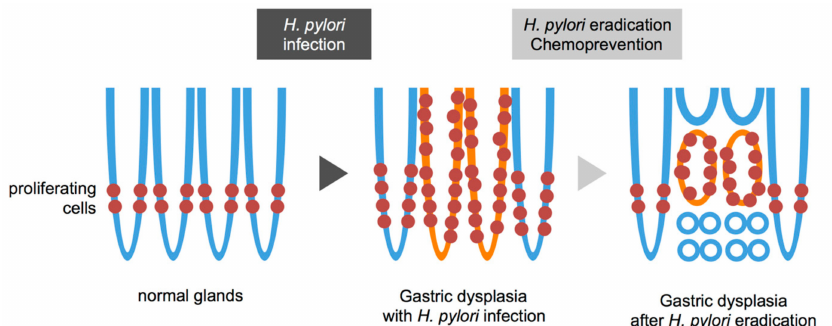
Figure 3. Schematic view of gastric dysplasia (intramucosal adenocarcinoma) before and after eradication of Helicobacter pylori (H. pylori) . Normal glands have proliferating cells in the lower narrow region ( left ). H. pylori infection widens proliferating zone in the normal glands ( middle , blue line ). Gastric dysplasia shows expanding proliferation with H. pylori infection and inflammation ( middle , orange line ). The tumor is shown around the proliferative zone ( right , orange line ) with subsequent regression at the top and bottom regions that are then occupied by adjacent normal epithelia ( right , blue line ) after